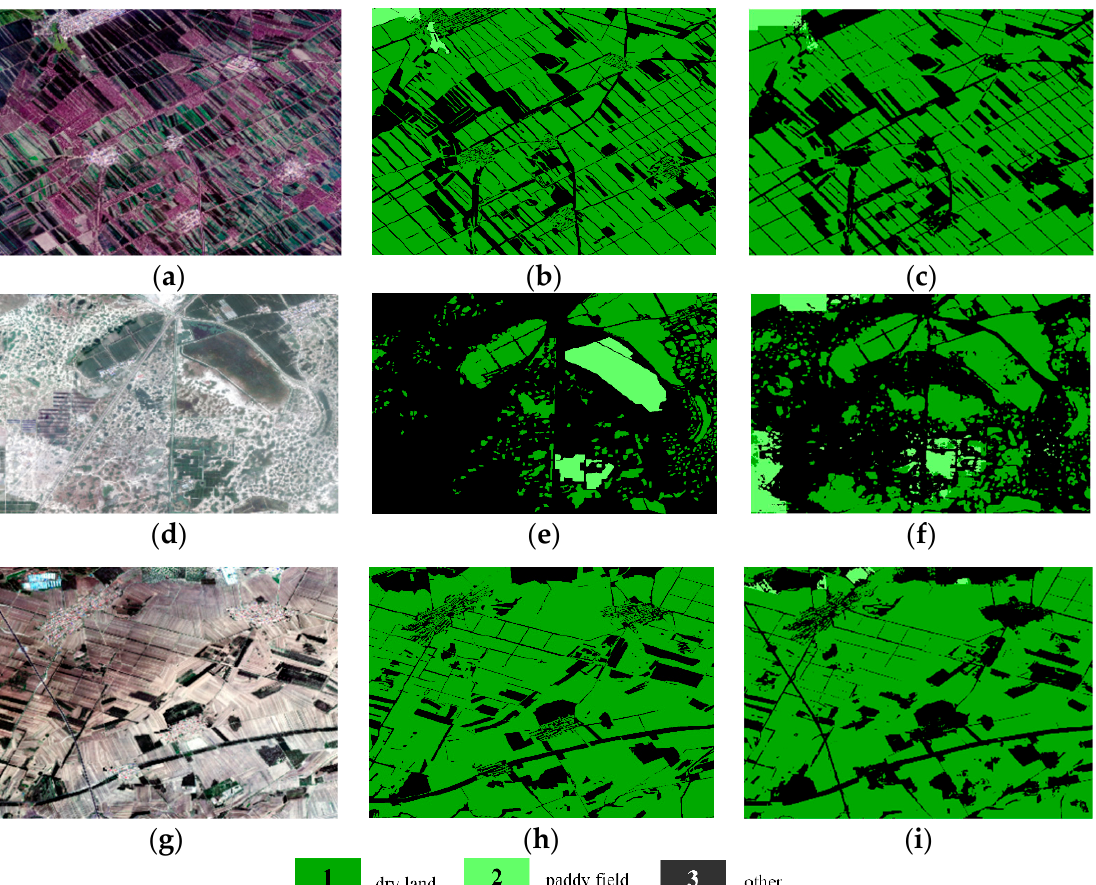
Figure 11. Visualization results of multi-region and multi-temporal cropland extraction in Jilin province: ( a ) true-color image of Songyuan research area in August, ( d ) true-color image of Baicheng research area in July, ( g ) true-color image of Sipin research area in May, ( b,e , h ) ground truth of cropland, and ( c , f , i ) semantic segmentation results of our method.